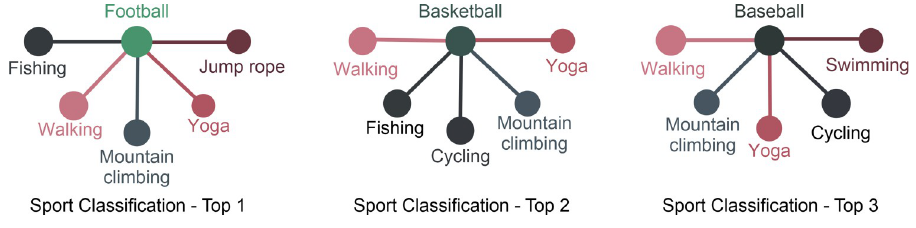
Fig 8. Highly connected sports (Sport